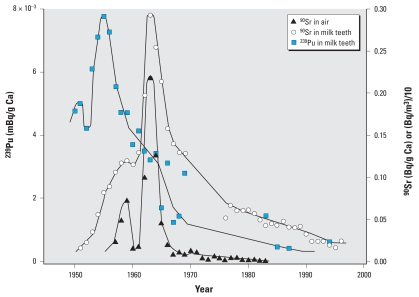
Activities of 90Sr and 239Pu in milk teeth as a function of the year of birth. Nuclear bomb tests conducted between 1955 and 1963 produced large amounts of 239Pu and 90Sr in air. 239Pu activities in the air can be deduced from 90Sr in the air [data from UNSCEAR (2000) for the Northern Hemisphere] with a factor of 1/95.